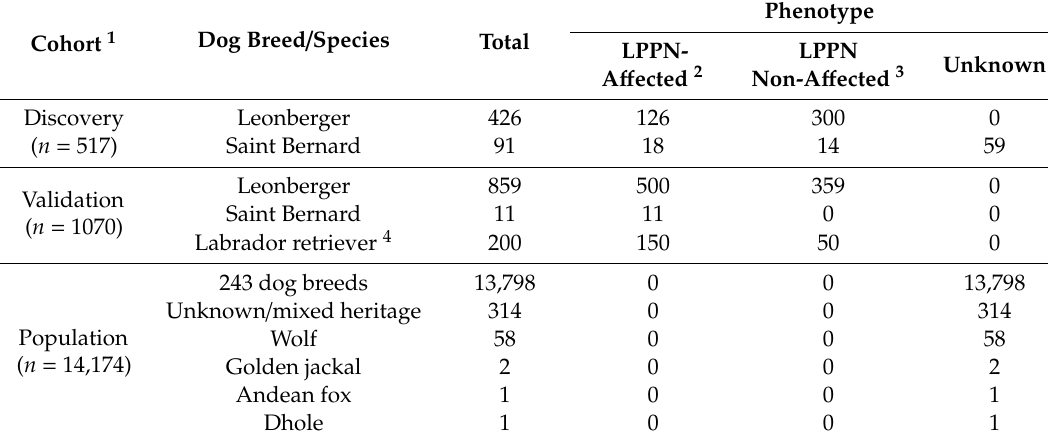
Table 1. Number of canids in each studied